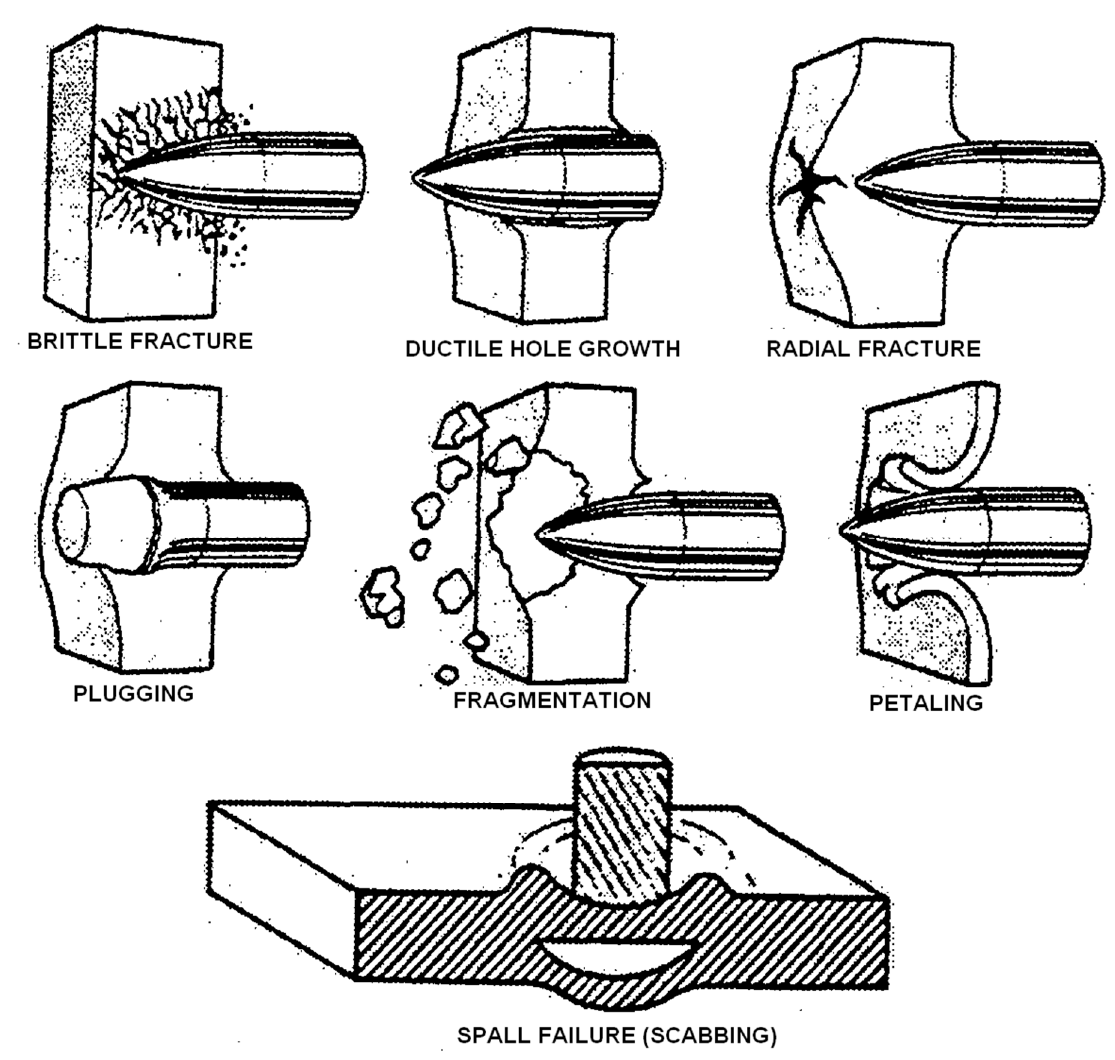
Figure 4. A comparison of the mode of penetration due to hybridization. (Original picture from the author of the chapter). Materials 2019 , 12 , x FOR PEER REVIEW